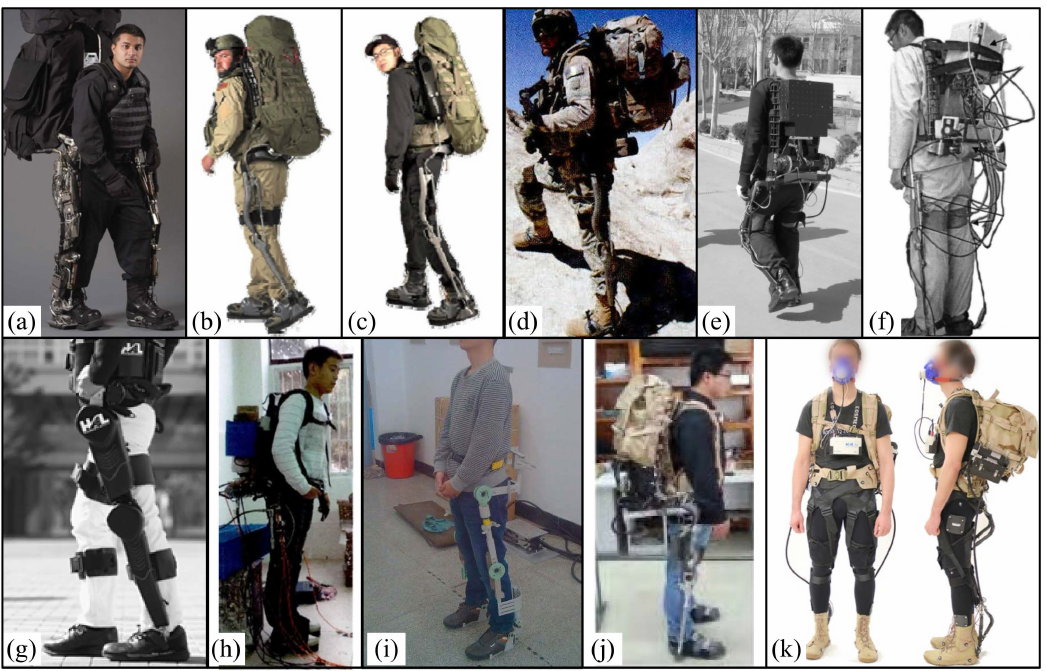
Figure 3. Multi-joint powered lower limb assisted exoskeleton. ( a ) University of California, BLEEX [8]. ( b ) ExoHIKE [48]. ( c ) ExoClimber [48]. ( d ) Lockheed Martin, HULC [43]. ( e ) Naval